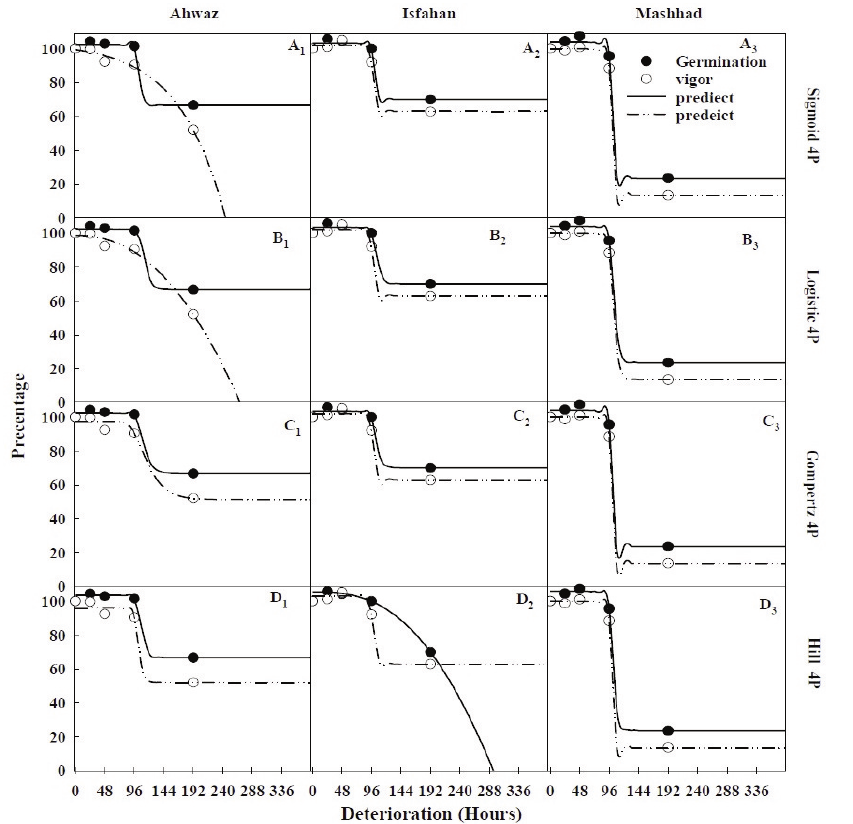
Fig. 5 - Model fit function 4 parameter of process deterioration germination and vigor ecotypes okra ( Abelmoschus esculentus L.). Points are the percentage of improvements in seed properties compared with control treatment (no aged seeds ) (● germination per- centage, ○ seedling vigor) and lines are predicted values.